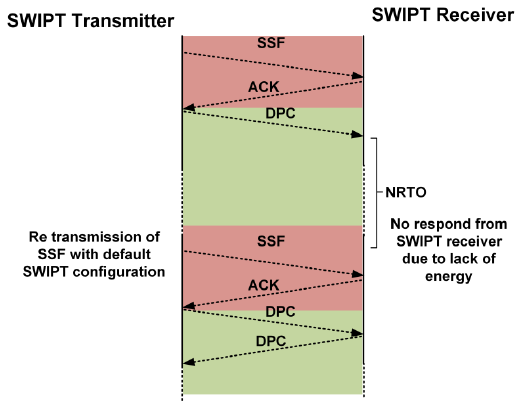
Figure 14. Re-synchronization by the SWIPT transmitter when there is no response from the SWIPT receiver.